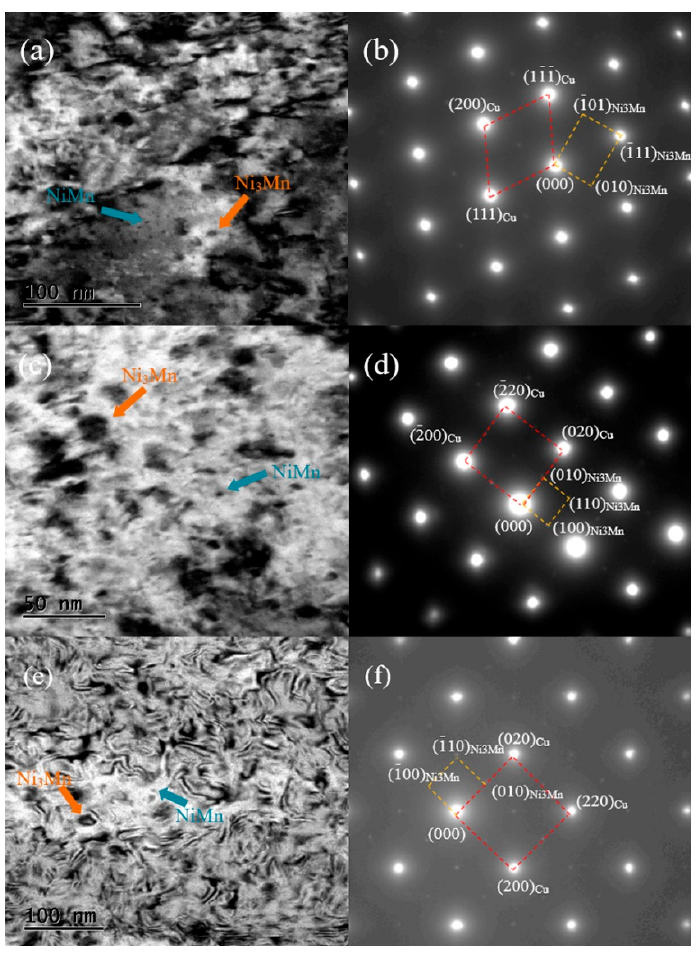
Figure 4. TEM micrographs and SAED patterns of the rolled specimens aged at 450 °C for 2, 10 or 48 h: ( a ) TEM micrograph and ( b ) [011] Cu SAED pattern of the rolled specimen aged for 2 h, ( c ) TEM micrograph and ( d ) [001] Cu SAED pattern of the rolled specimen aged for 10 h, and ( e ) TEM micrograph and ( f ) [001] Cu SAED pattern of the rolled specimen aged for 48 h.